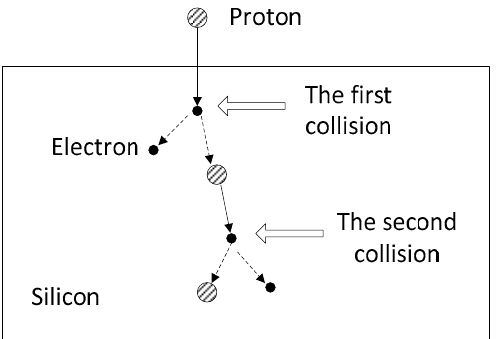
Figure 8. The schematic diagram of collisions between protons and extranuclear electrons of silicon.